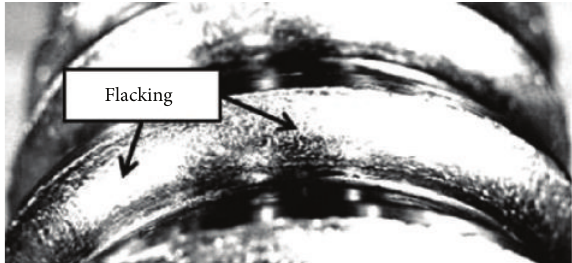
Figure 2: Example of fatigue failure: